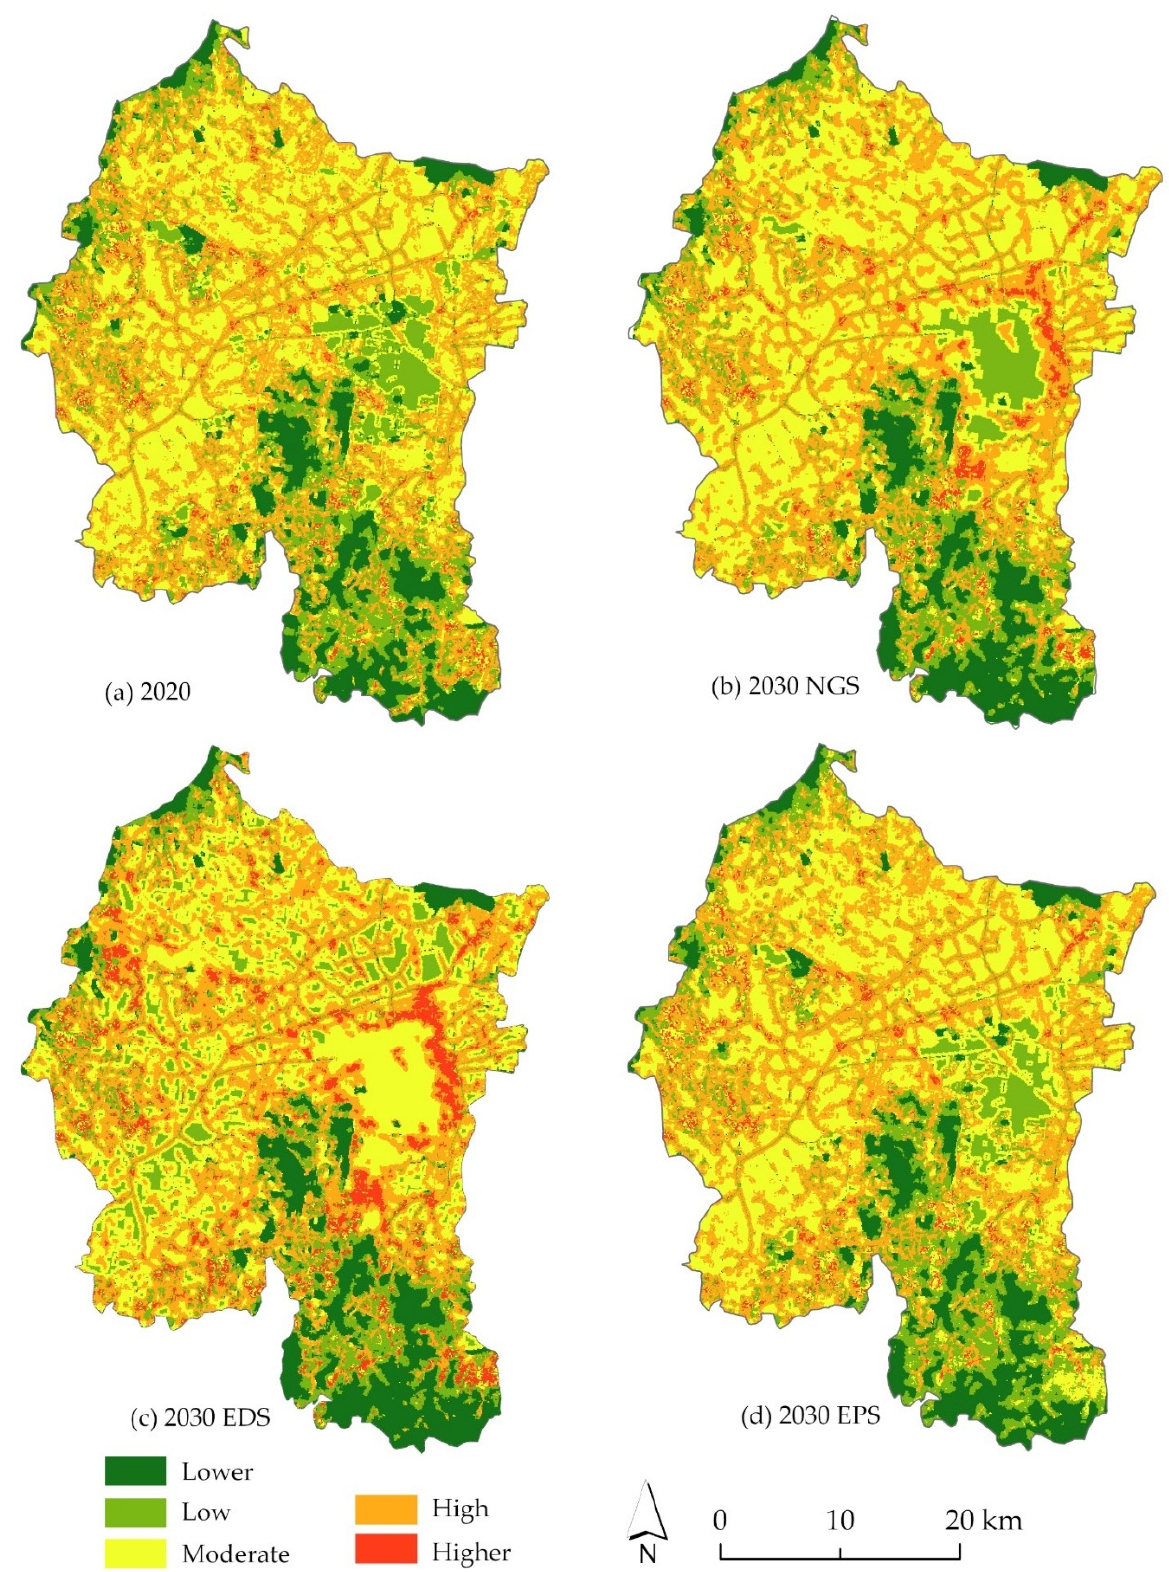
Figure 8. Spatial distribution of land use con fl icts.